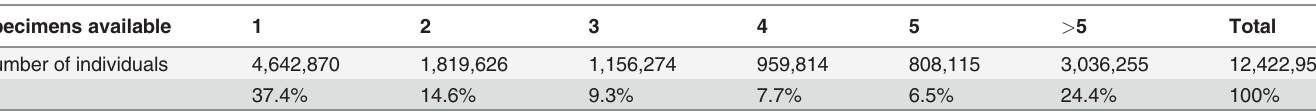
Table 2. The numbers of individuals who provided specimens to the DoD Serum Repository and the numbers of specimens per person. Specimens